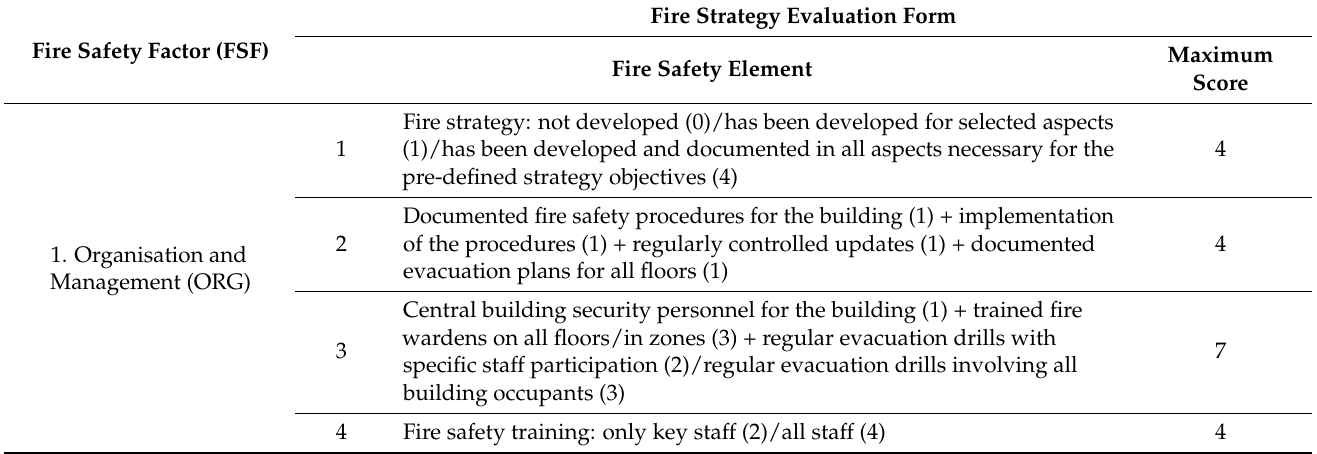
Table 4. Actual fire strategy elements